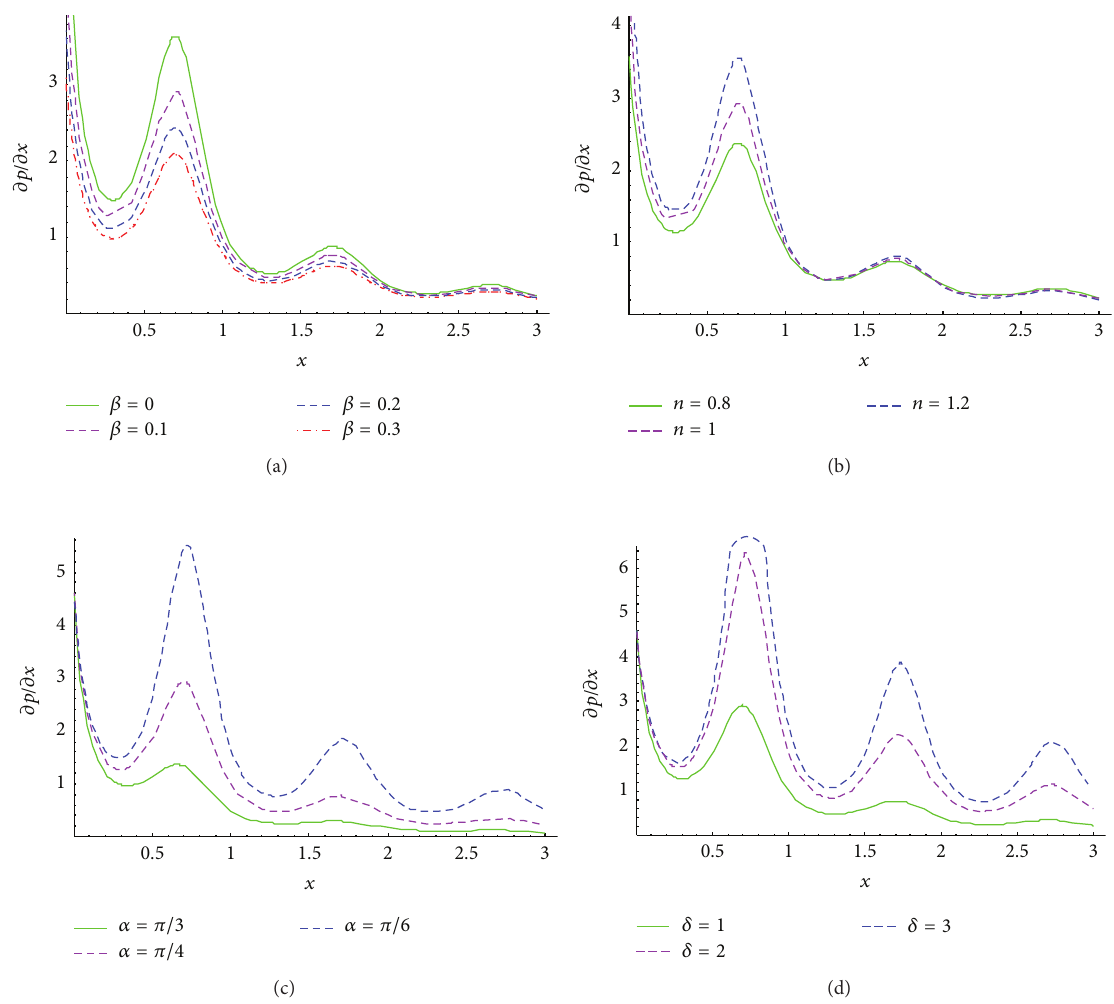
Figure 4: Pressure gradient versus axial displacement at 𝜙 = 0 . 5, 𝑞 = 1 for (a) 𝑛 = 1, 𝛼 = 𝜋/ 4, 𝛿 = 1, and various values of slip parameter 𝛽 = 0 , 0 . 1 , 0 . 2 , 0 . 3, (b) 𝛽 = 0 . 1, 𝛼 = 𝜋/ 4, 𝛿 = 1, and various values of fluid behavior index 𝑛 = 0 . 8 , 1 , 1 . 2, (c) 𝛽 = 0 . 1, 𝑛 = 1, 𝛿 = 1, and various values of inclination of channel 𝛼 = 𝜋/ 3 , 𝜋/ 4 , 𝜋/ 6, and (d) 𝛽 = 0 . 1, 𝑛 = 1, 𝛼 = 𝜋/ 4, and various values of wave number 𝛿 = 1 , 2 ,